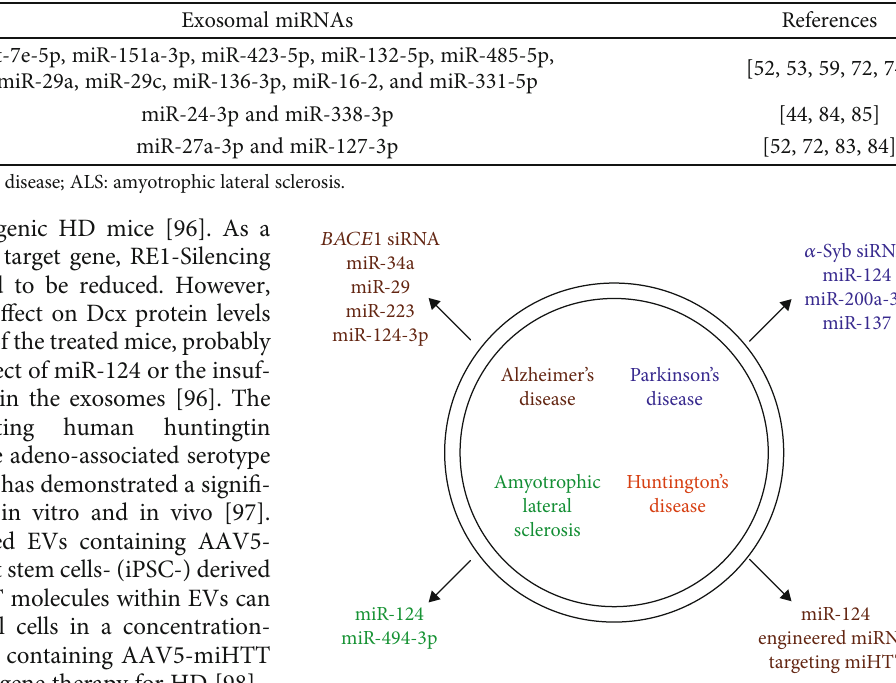
Figure 2: Exosomal miRNAs and siRNAs as potential therapeutic strategy for neurodegenerative disorders. miHTT: human